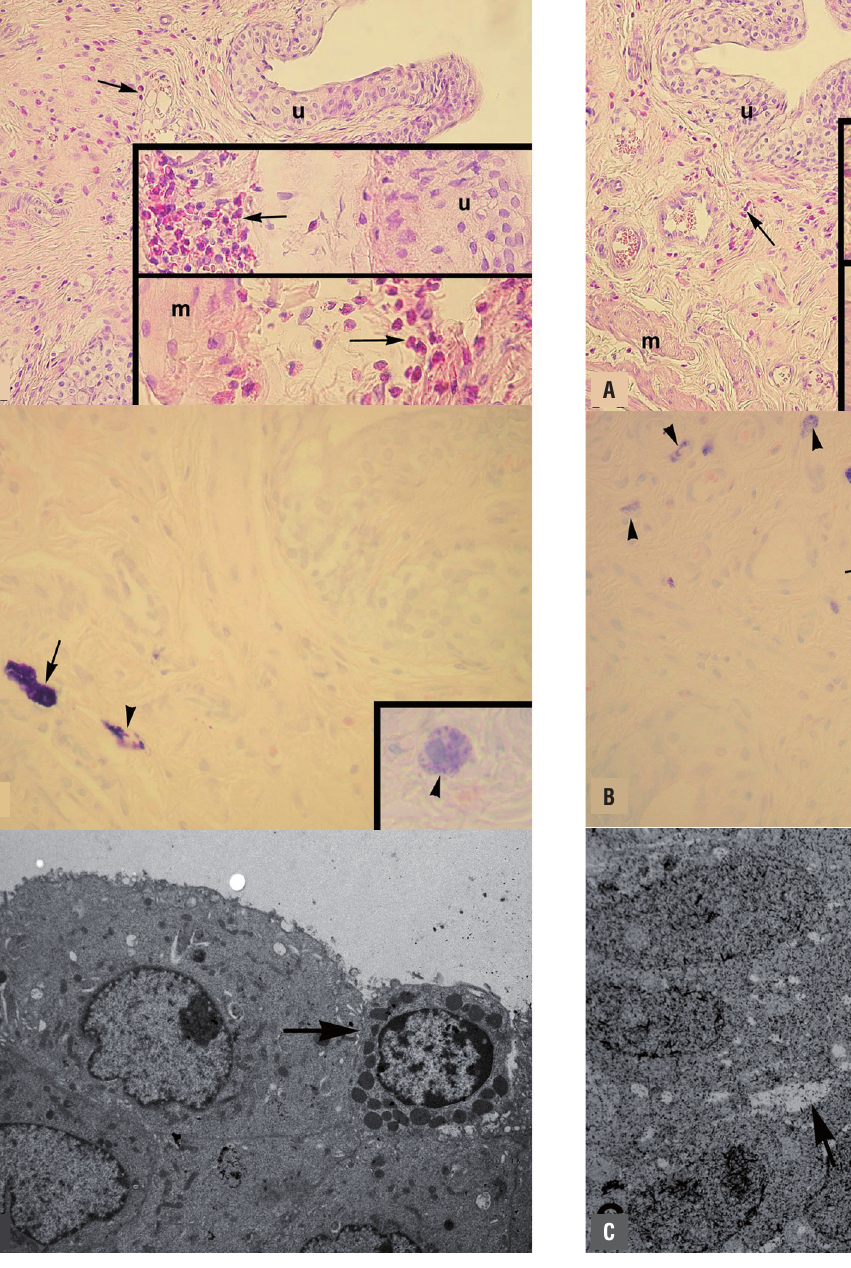
Figure 3 (Group 3): Regular morphology in urothelium (u), severe inflammatory cell infiltration (arrow) in lamina propria and muscle layers (m) (A), severe increase in both granulated (arrow) and degranulated (arrowhead) mast cells (B) in lamina propria, many vacuoles in the cytoplasm of urothelial cells (arrow) (C). A) H&E staining, original magnifications: x100, inserts: x200, B) Toluidine blue staining, original magnification: x400, inserts: x1000, C) Electron micrograph, original magnification: